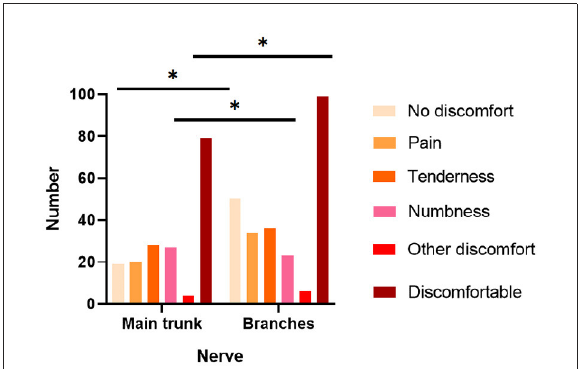
FIGURE2 Relationship between the nerve of origin of the mass and the symptoms. p -value * < 0.05.